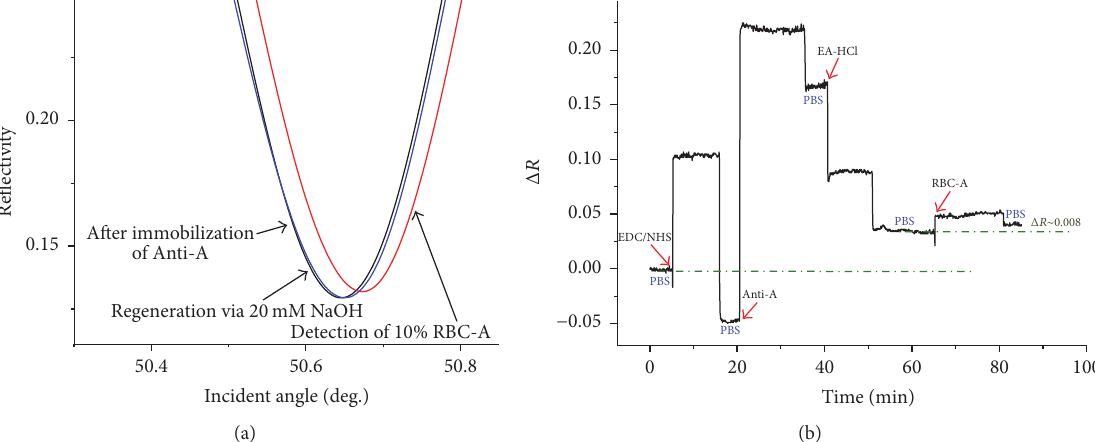
Figure 4: (a) Angular reflectivity curves of LR-SPR after immobilization of Anti-A, after detection of RBC-A, and after regeneration with 20 mM NaOH. (b) Corresponding LR-SPR kinetic reflectivity